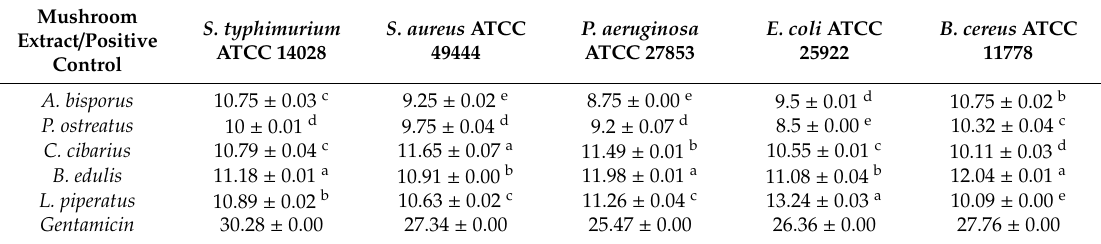
Table 3. Antibacterial activity of mushroom extracts (zone of inhibition including the diameter of the paper disk, mm).